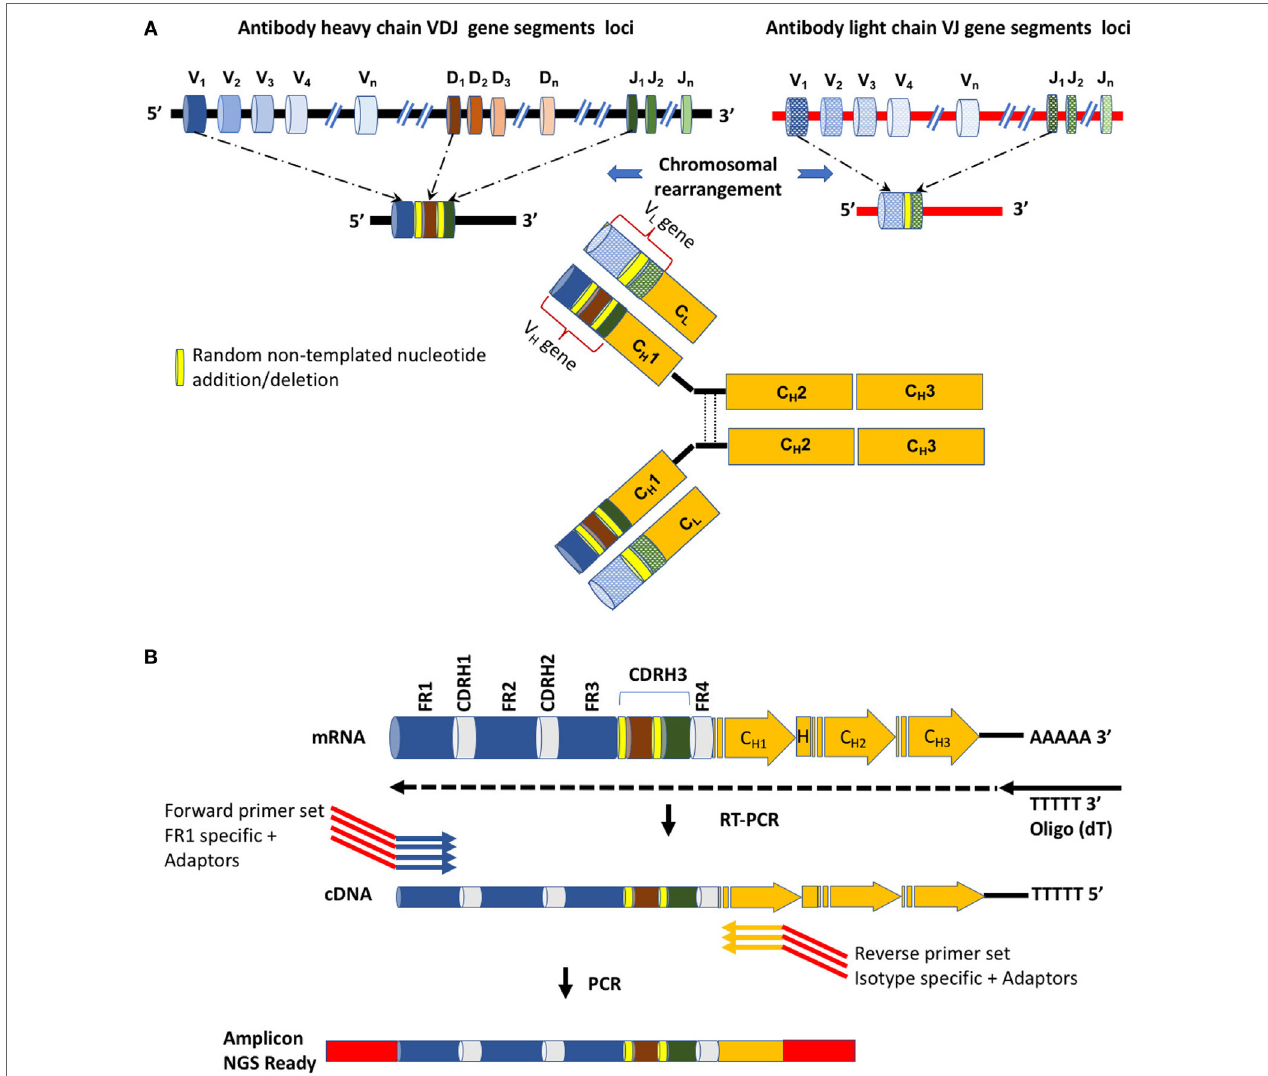
FIguRe 1 | The diversity of antibody sequences and structures and molecular methodologies for next-generation sequencing. (A) Antibodies are comprised of two identical heavy chains and two identical light chains, each encoded on a different chromosome, both in human and in mouse. Diversity is achieved by chromosomal rearrangement, where different V, D, and J (V and J) genes are combined to construct the variable region of the heavy (light) chain of the antibody. In yellow are random nucleotides introduced during the chromosomal rearrangement process. (B) A detailed view of the variable region. Shown are the forward and reverse primers used for amplification. Several alternative primers, both forward and reverse, are used in order to capture the diversity of the variable region and its associated isotypes. The forward primers anneal to the framework 1 (FR1) region. Red regions within the primers represent adaptor sequences.